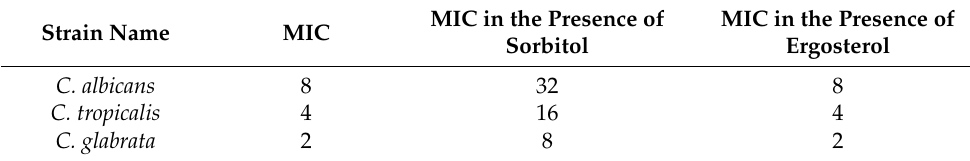
Table 1. Minimal inhibitory concentration (MIC) values for CTAC against Candida species in the presence or absence of sorbitol or